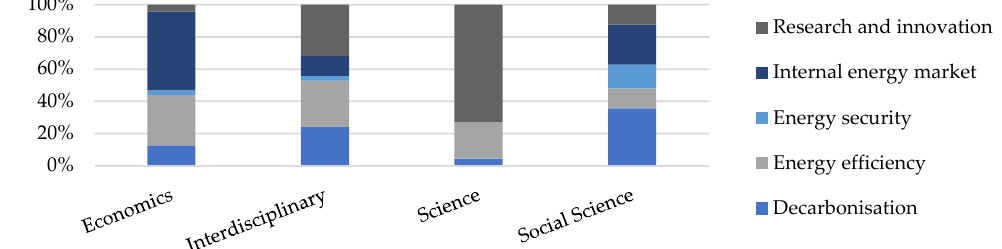
Figure 11. Relation between disciplines and the Energy Union dimensions. Source: Authors; N = 3534.